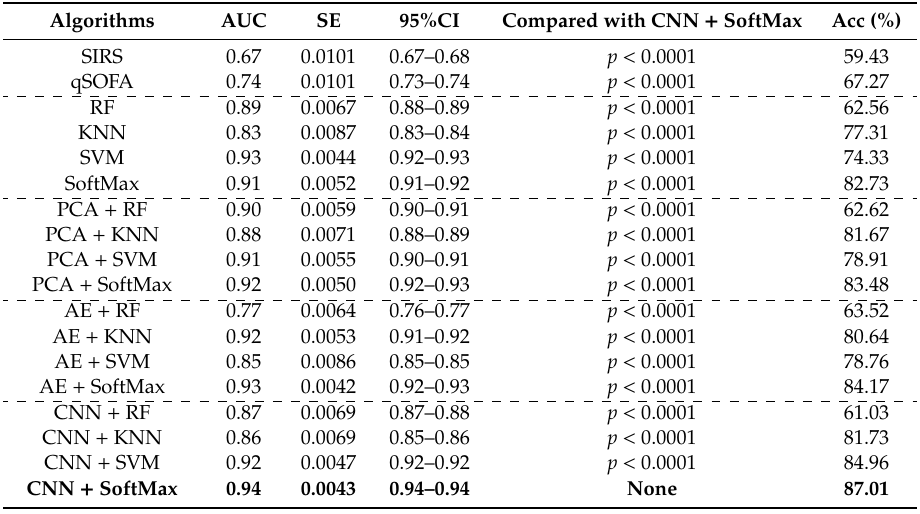
Figure 7. AUC curve of the mortality prediction of the testing dataset in 28 d: ( a ) no feature extraction, ( b ) PCA, ( c ) AE, ( d ) CNN. Abbreviation: SIRS, systemic inflammatory response syndrome; qSOFA, quick sepsis-related organ failure assessment; RF, random forest; KNN, K nearest neighbor; SVM, support vector machine; PCA, principal component analysis; AE, autoencoder; CNN, convolutional neural network. Table 1. AUC with 95% confidence interval and the accuracy rate of various methods in predicting 72-h mortality and compared with CNN plus SoftMax by Delong test.